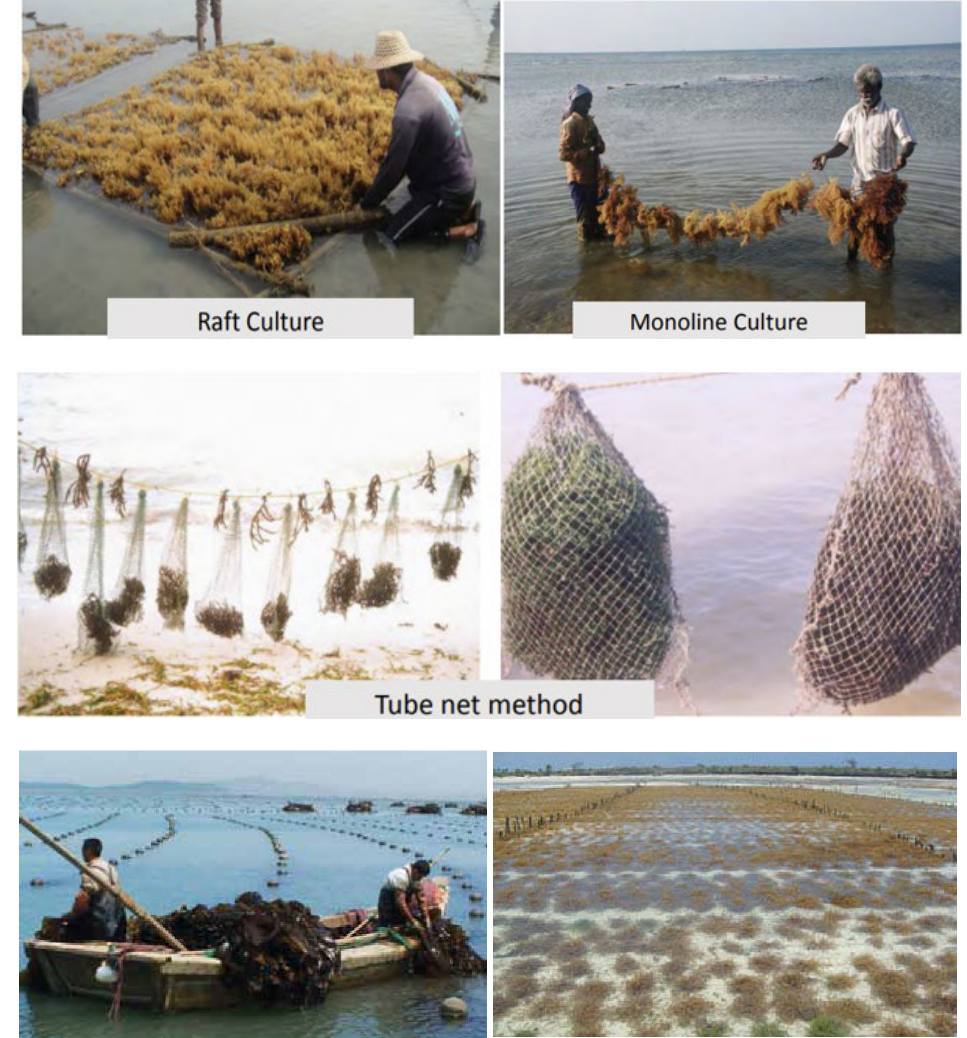
Figure 1. Simple seaweed systems—raft, monoline, tube nets - images from https://www.slideshare.net/zoysa89/sea-weed-farmingsouth-east-asia (accessed on 22 September 2022), floating longlines ( bottom left ) [1], staked rope bottom culture ( bottom right ) [1].